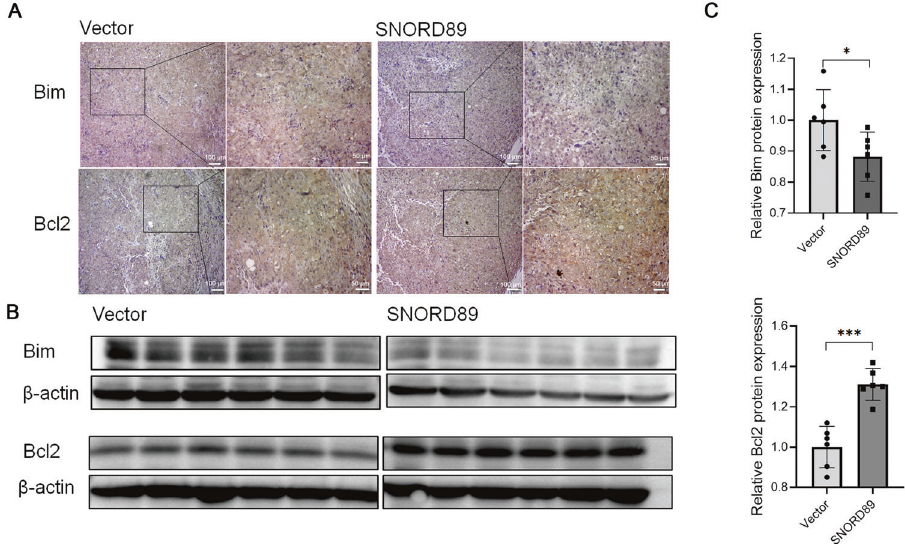
Fig. 6 Effect of SNORD89 overexpression on xenograft tumors in nude mice. A – C SNORD89 overexpression can reduce the expression of Bim protein and increase the expression of Bcl2 protein in vivo ( n = 6). All results are representative of at least three independent experiments. Values are presented as the mean ± SD. * p ≤ 0.05; ** p ≤ 0.01; *** p ≤